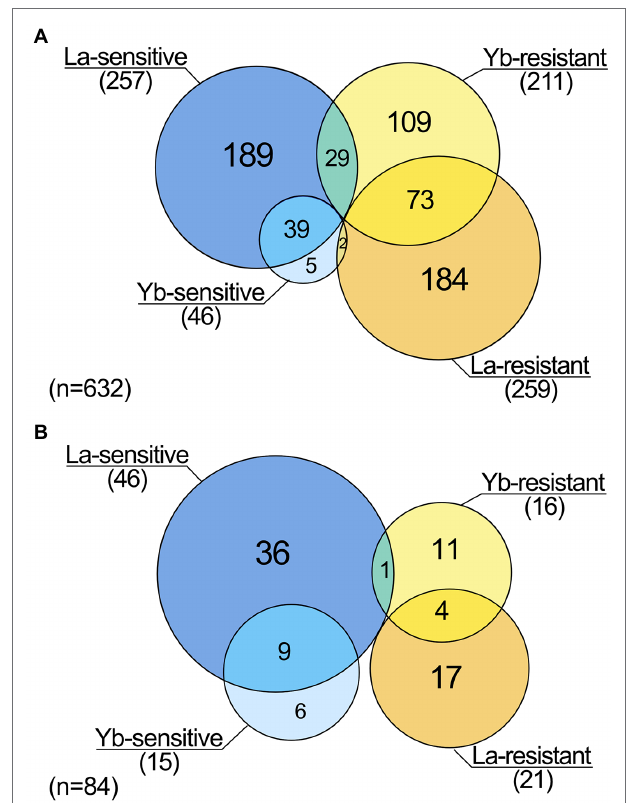
FIGURE 1 | Lanthanide response patterns obtained from genomic phenotyping of a whole mutant collection of Saccharomyces cerevisiae . (A) Venn diagram highlighting the number of mutants being sensitive or resistant to La and/or to Yb. (B) Venn diagram highlighting the number of mutants displaying an exacerbated phenotype (highly resistant/sensitive) toward La and/or